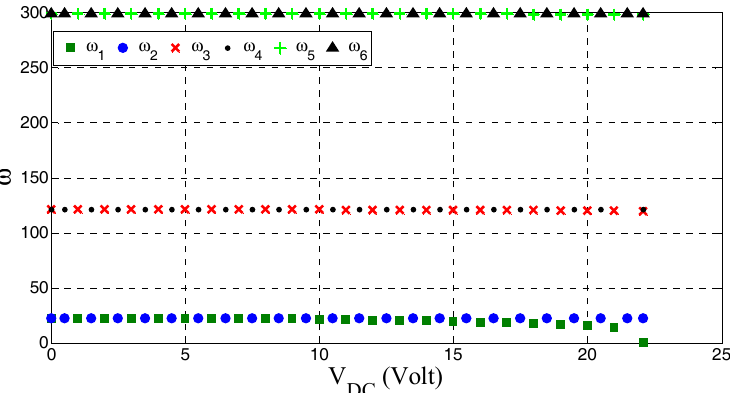
Figure 8. Variation of the first six natural frequencies with the applied DC voltage for the case of the double-microbeams based actuator and for d 1 = d 2 .